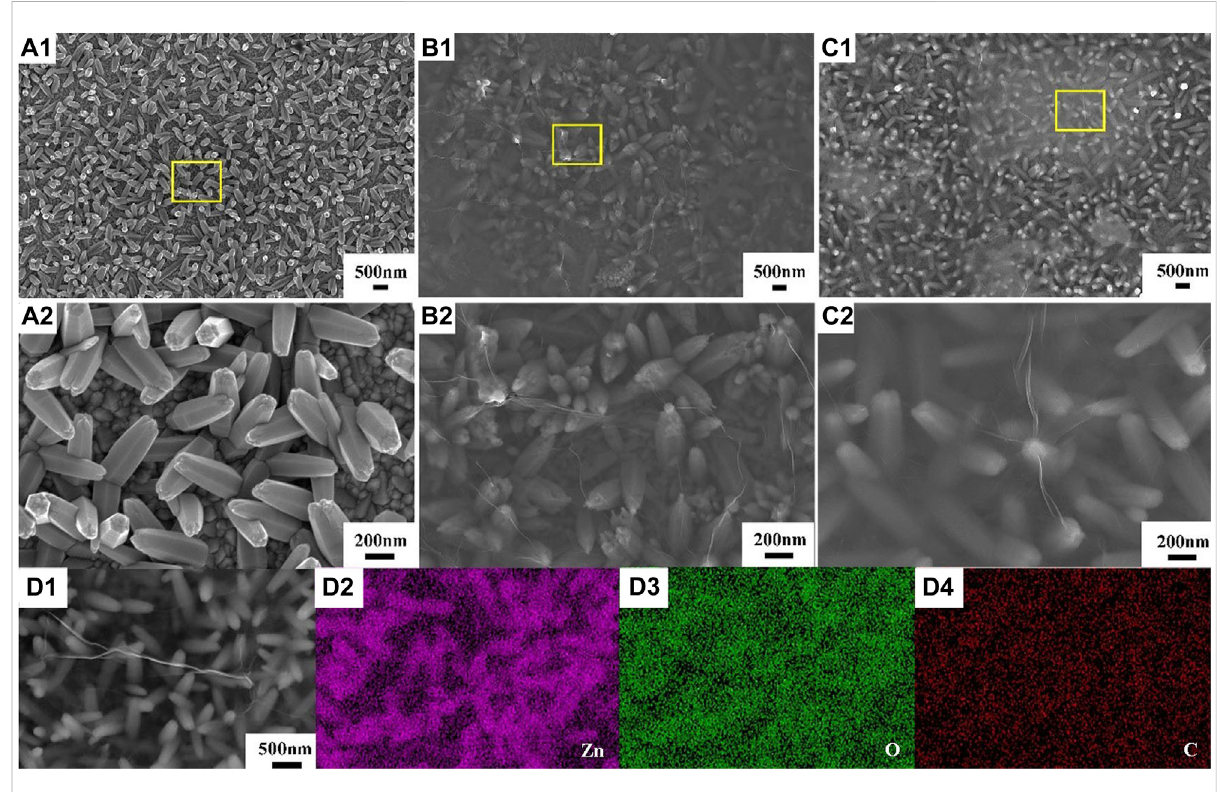
FIGURE 2 SEM micrographs of ZnO (A) , ZnO-rGO-N (B) , and ZnO-rGO (C) deposited on the FTO substrates, EDS elemental mapping of ZnO-rGO composite (D)